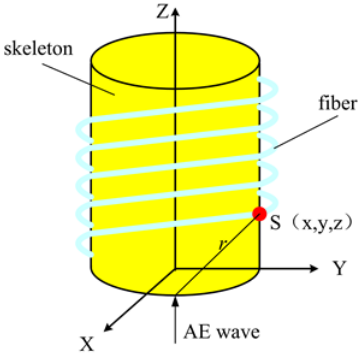
Figure 4. FOR AE sensor. Figure 4. FOR AE